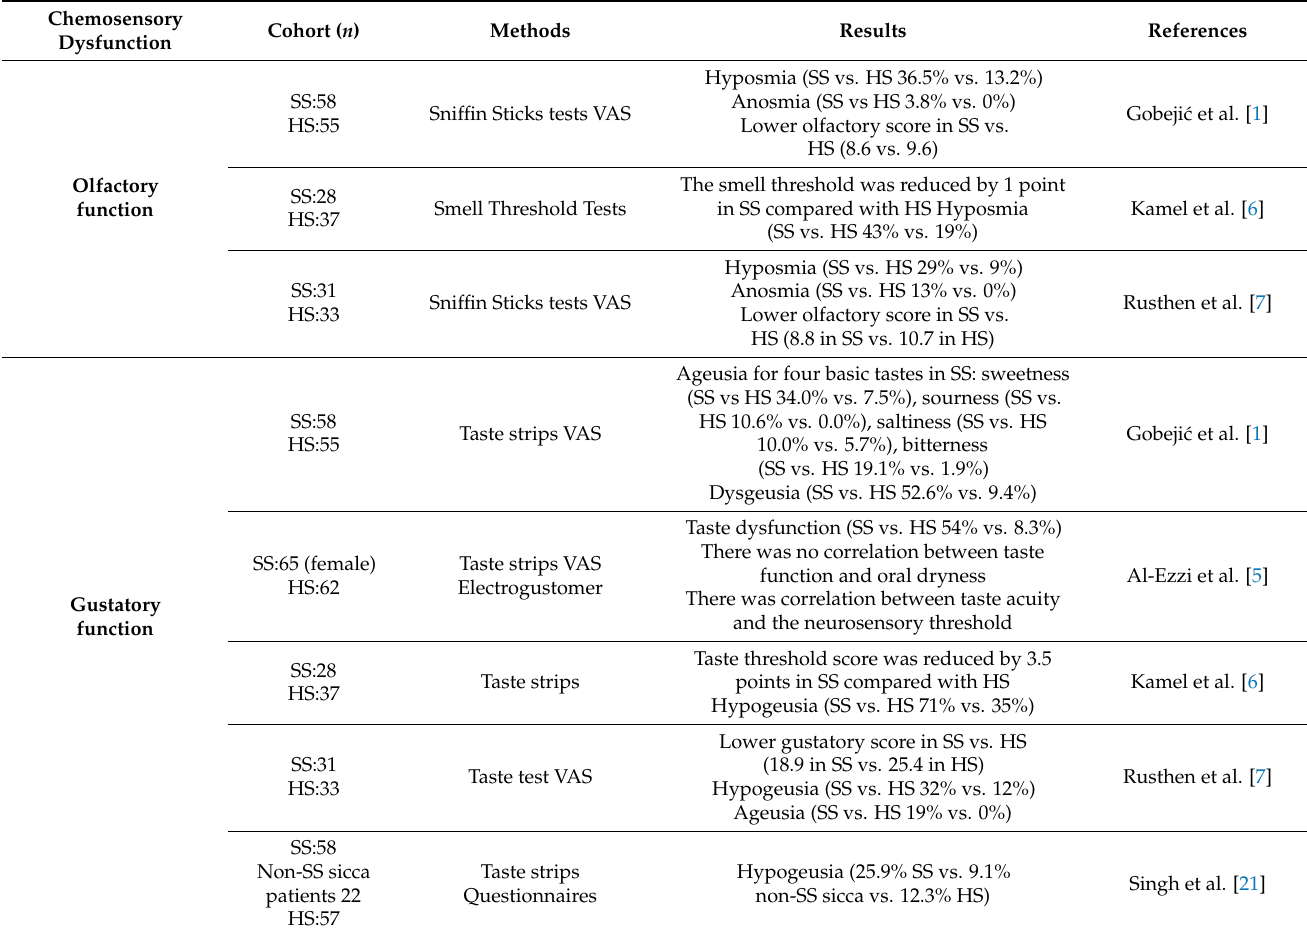
Table 1. The findings related to taste and smell disorders in